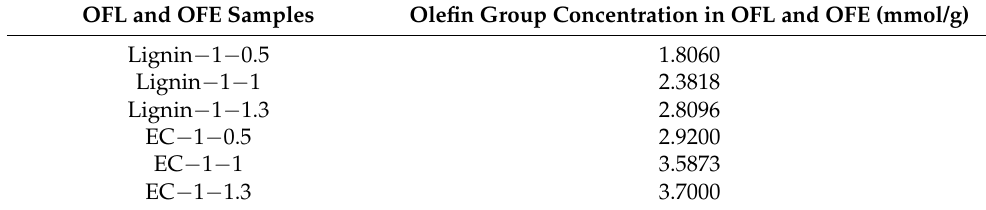
Figure 6. 1 H NMR of OFE with the interior label compared with EC. Table 2. Olefin group concentration in OFL and OFE.